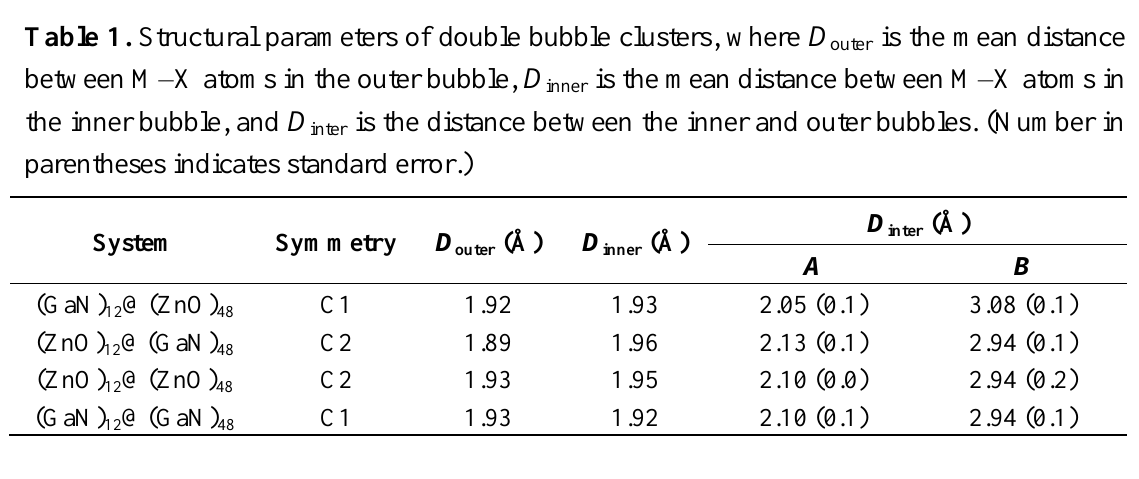
Figure 5. Bond distribution plots for the double bubble cluster systems. Red line: Dispersion of Gaussian = 0.02, Blue line: Dispersion of Gaussian =